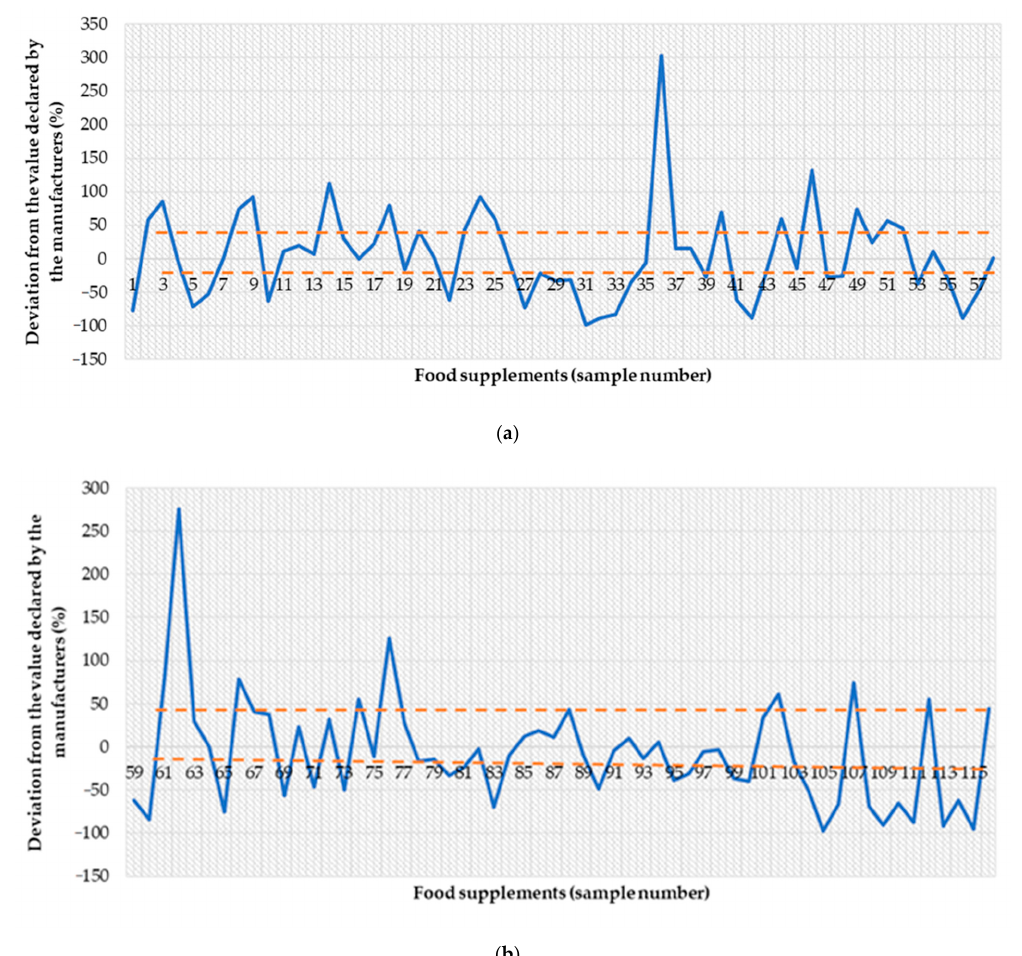
Figure 1. The discrepancy between the declared magnesium content and that determined in dietary supplements ( a ) samples of food supplements from 1 to 58, ( b ) samples of food supplements from 59 to 116. At a further stage, we also assessed by how many percent the expected value by con- sumers would differ from the actual value consumed, in accordance with the manufac- turer’s recommendation, because the tested FS can be taken in amounts greater than just one portion per day. It has been shown that for 54.1% of FS, consumers will consume a lower amount of Mg. For example, for 3.4% it will be 90–100% less than the expected value. Worryingly, in the case of one of the studied FS, consumers, using one portion of the FS each day, will consume as much as 300% more Mg than indicated on the packaging (Figure 2).